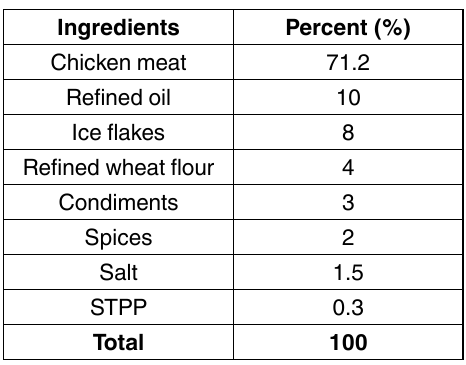
table 1. Formulation for the preparation of chicken sausage